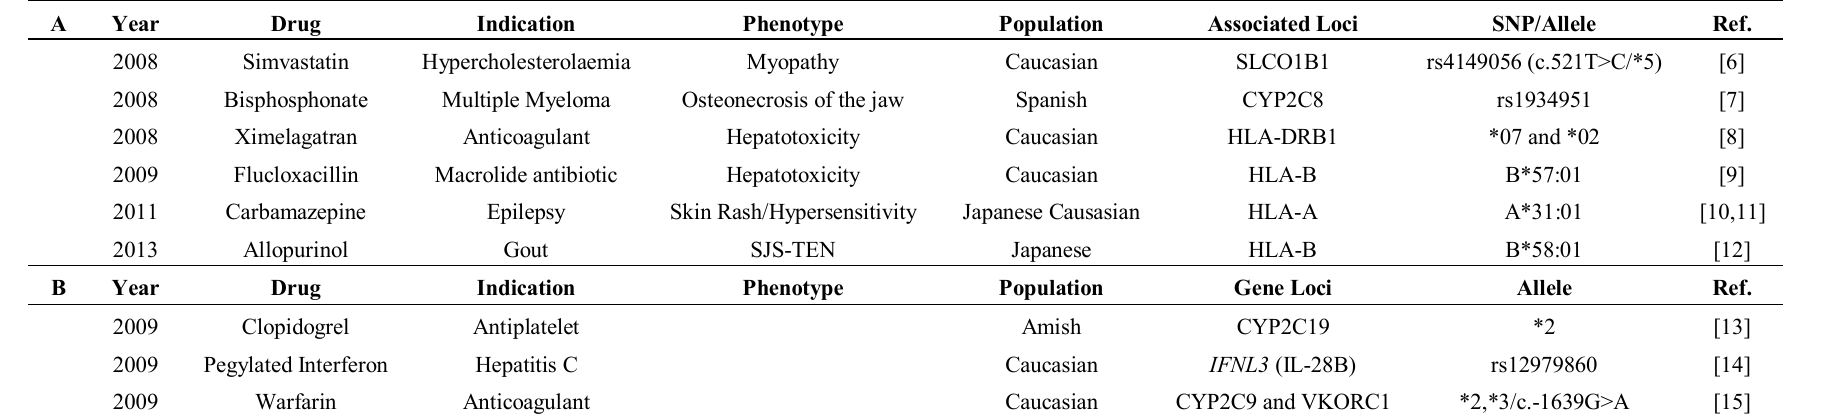
Table 1. Genetic biomarkers of ( A ) adverse drug reactions and ( B ) inter-individual variability of drug efficacy identified, or confirmed, from genome wide association studies